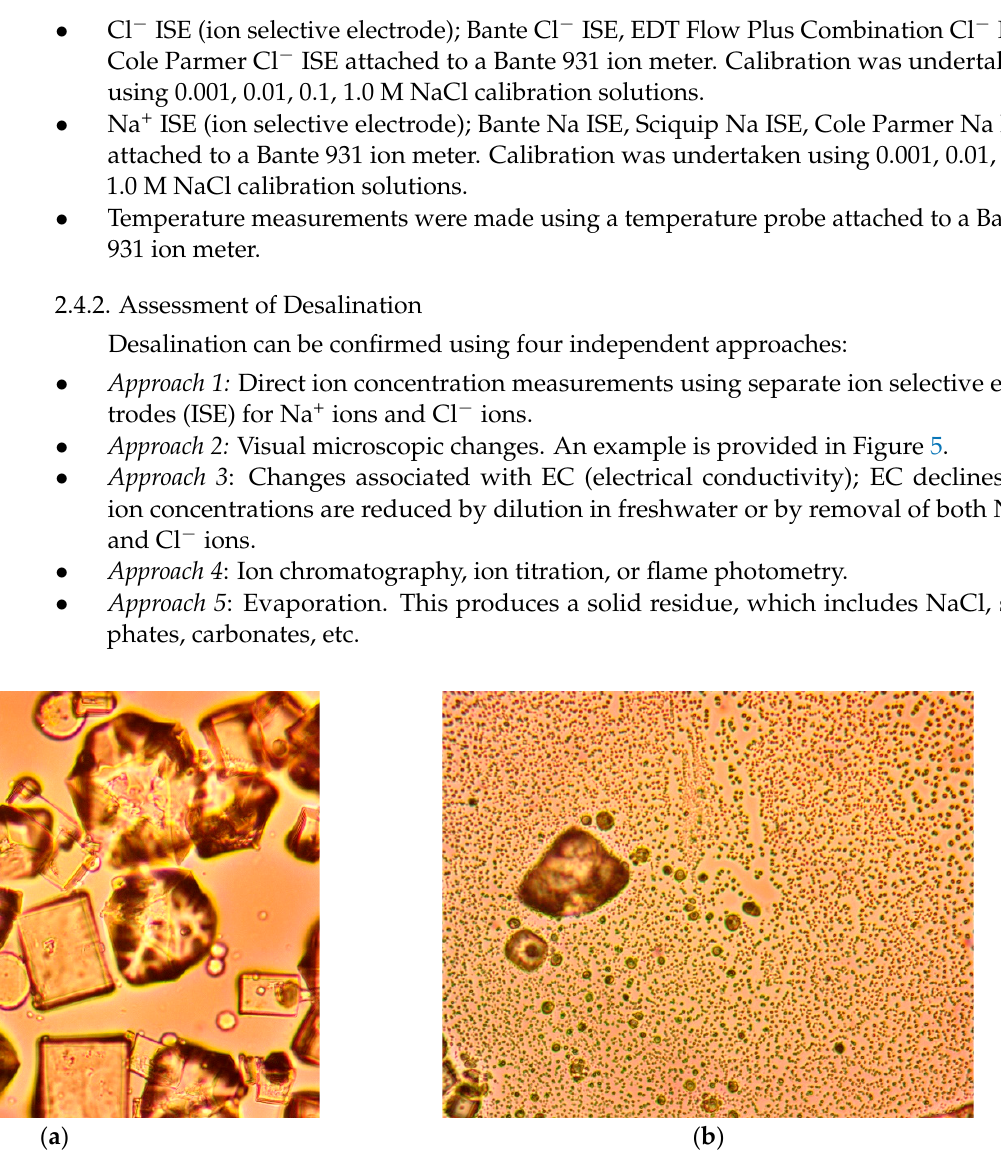
Figure 5. Example transmitted light photomicrographs associated with ZVI partial desalination. ( a ) Evaporated feed water, showing halite crystals; ( b ) evaporated partially desalinated product water, showing reduced halite crystals + flocculates. Field of view = 1 mm.